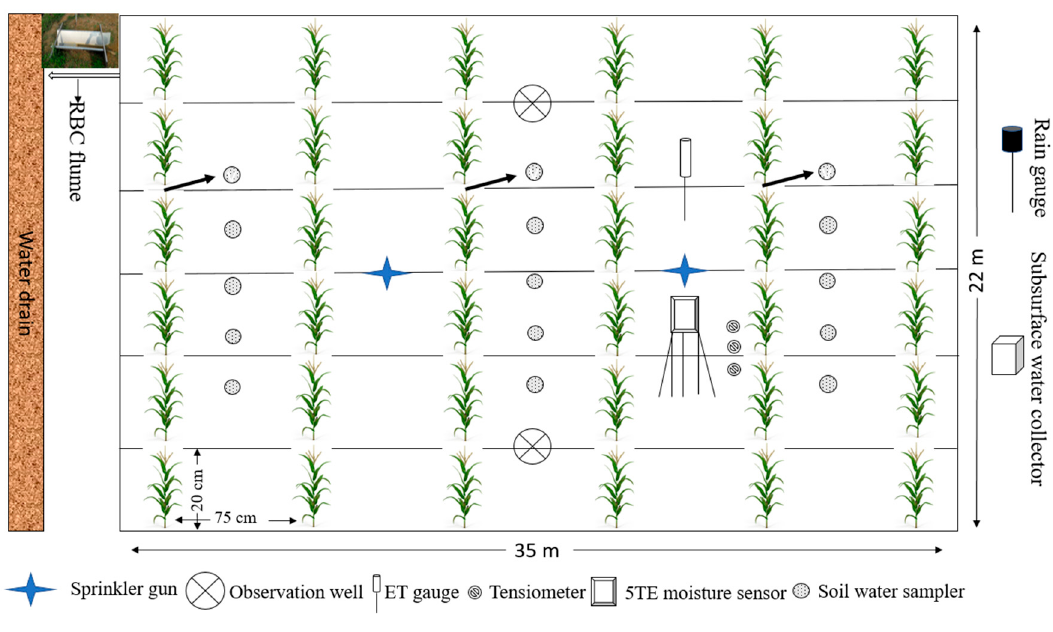
Figure 1. Field layout of equipment installed for investigation of water and Nitrogen (N) balance components.